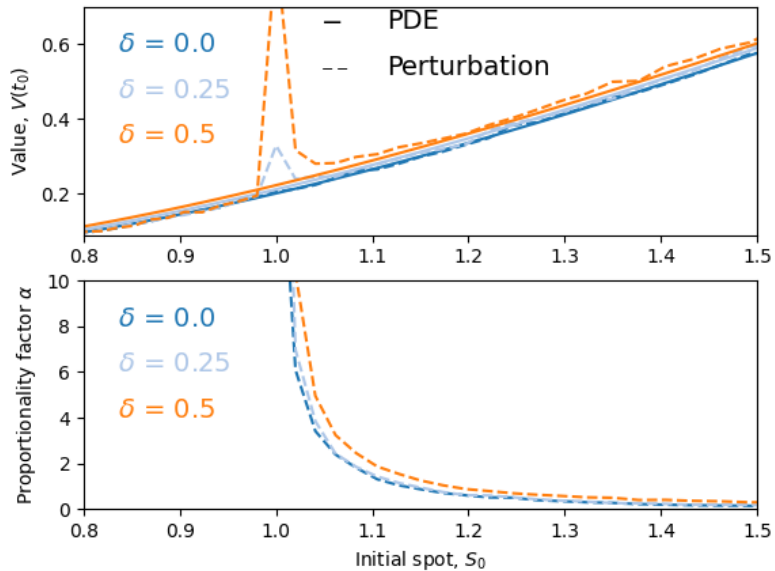
Figure 3. The value and the proportionality factor, α , as a function of the initial spot, S 0 , on an interval including the cross over from being out-of-the-money to being in-the-money at S 0 = 1 for different dividends rates, δ , and with 5 updates of the intrinsic value, N t =